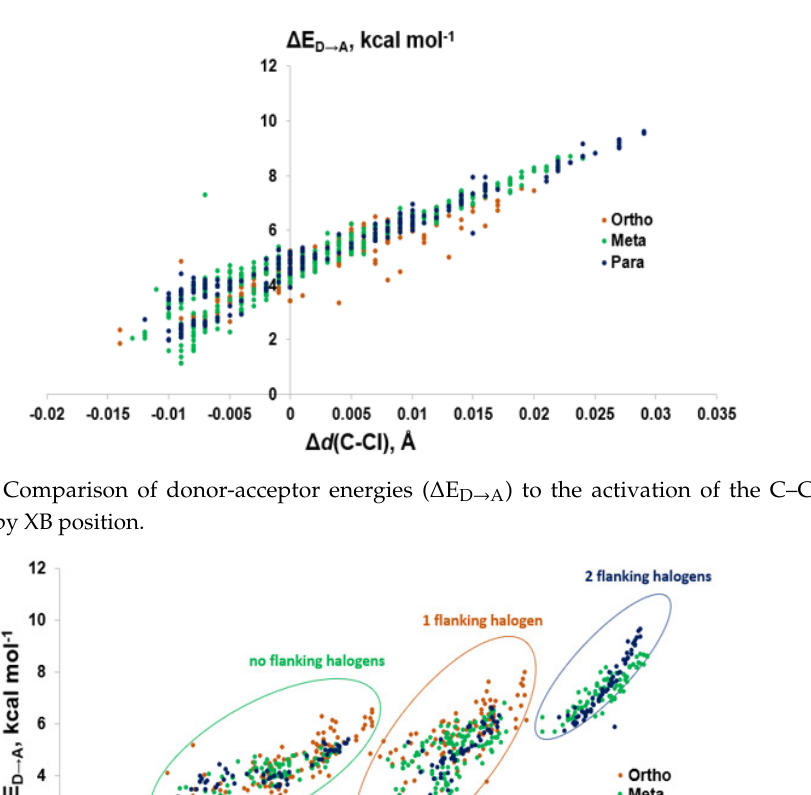
Figure 9. Comparison of XB interactions of THs, PBDEs, and PCBs. The red line indicates a proposed energy threshold needed for dehalogenation, based upon the interaction energy for 3-T 1 .